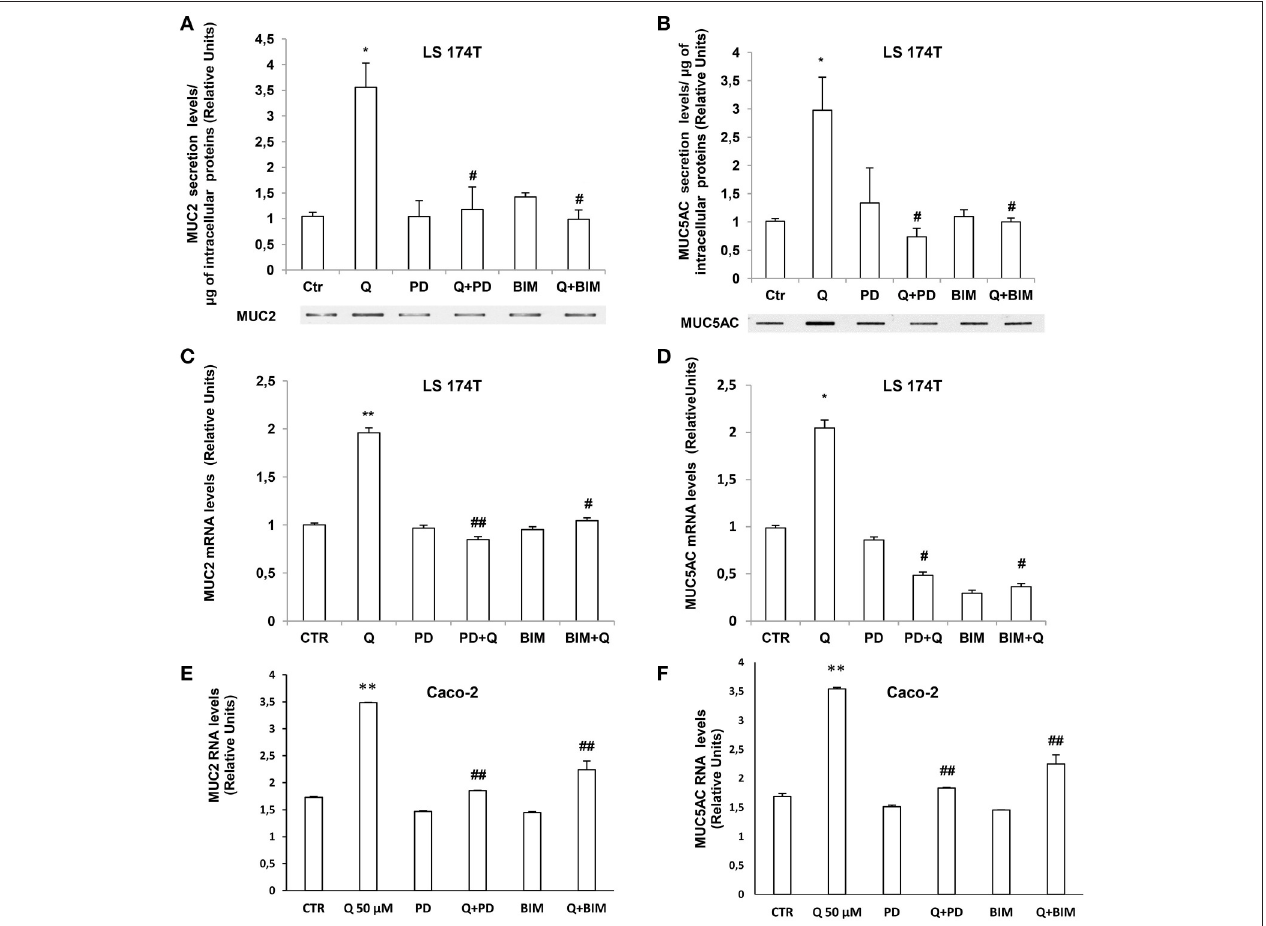
FIGURE 7 | Quercetin induction of mucin secretion and gene expression is PKC α and ERK1-2-dependent. (A,B) Slot-Blot analysis of incubation medium of LS174T cells grown for 24h, in MEM without FBS stimulated with 50 µ M quercetin in the absence or presence of BIM (PKC inhibitor) or PD98059 (MEK inhibitor). The histogram shows the mean ± SE of MUC2 (A) and MUC5AC (B) secretion levels obtained by densitometric analysis of protein bands normalized for the respective cell concentrations of three independent experiments. (C,F) Real-time-PCR analysis of MUC2 and MUC5AC m-RNA levels in LS174T (C,D) and Caco-2 cells (E,F) incubated for 24h with 50 µ M quercetin pretreated with PD98059 or BIM in medium without serum. Expression values were normalized using glucose-6-phosphate- dehydrogenase mRNA (G6PD). The histogram shows the mean ± SE ( n = 3) of mRNA levels of three independent experiments. * p < 0.05 vs. Ctr, ** p < 0.001 vs. Ctr, # p < 0.05 vs. Q, ## p < 0.001 vs.